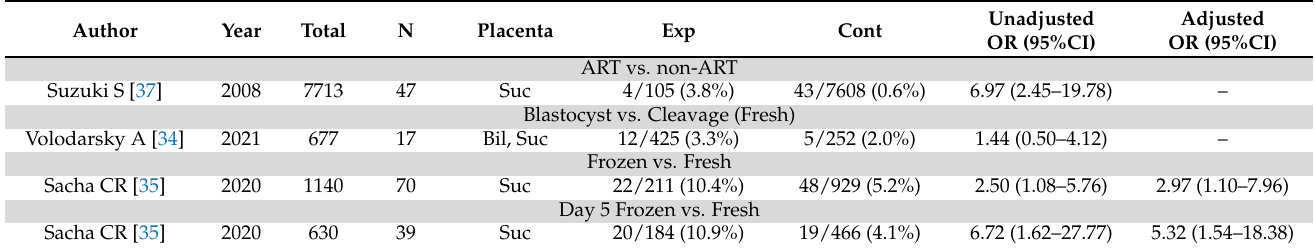
Table 4. The association between ART and abnormal